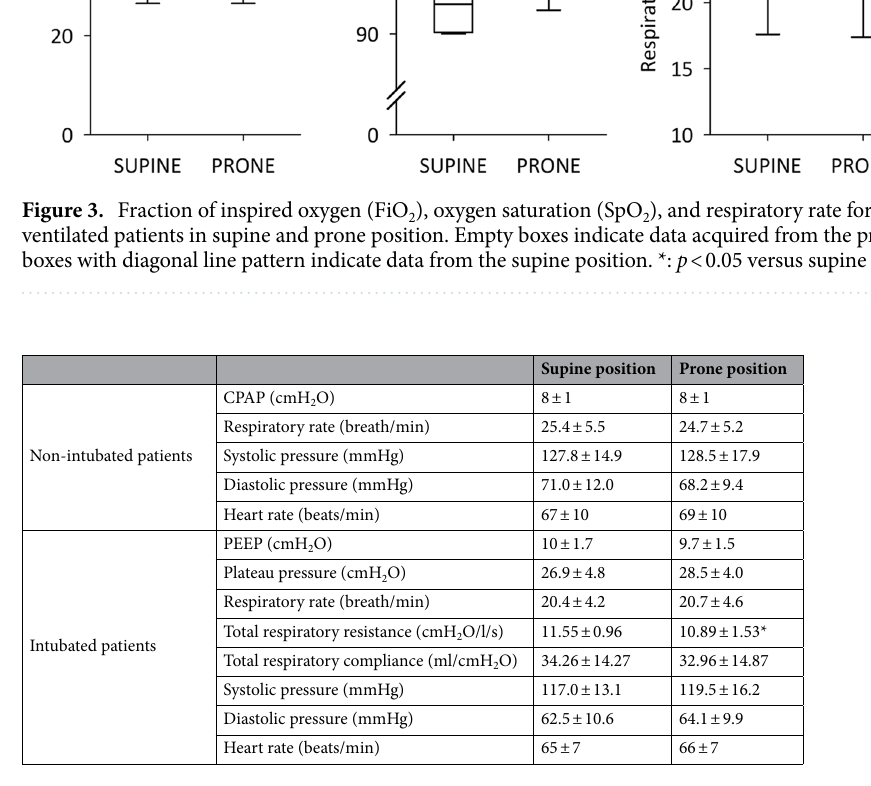
Table 2. Respiratory and haemodynamic data in prone and supine position for non-intubated and intubated patients. Values are presented as mean ± standard deviation. CPAP Continuous positive airway pressure, PEEP positive end-expiratory pressure. *: p < 0.05 versus supine position compared with paired